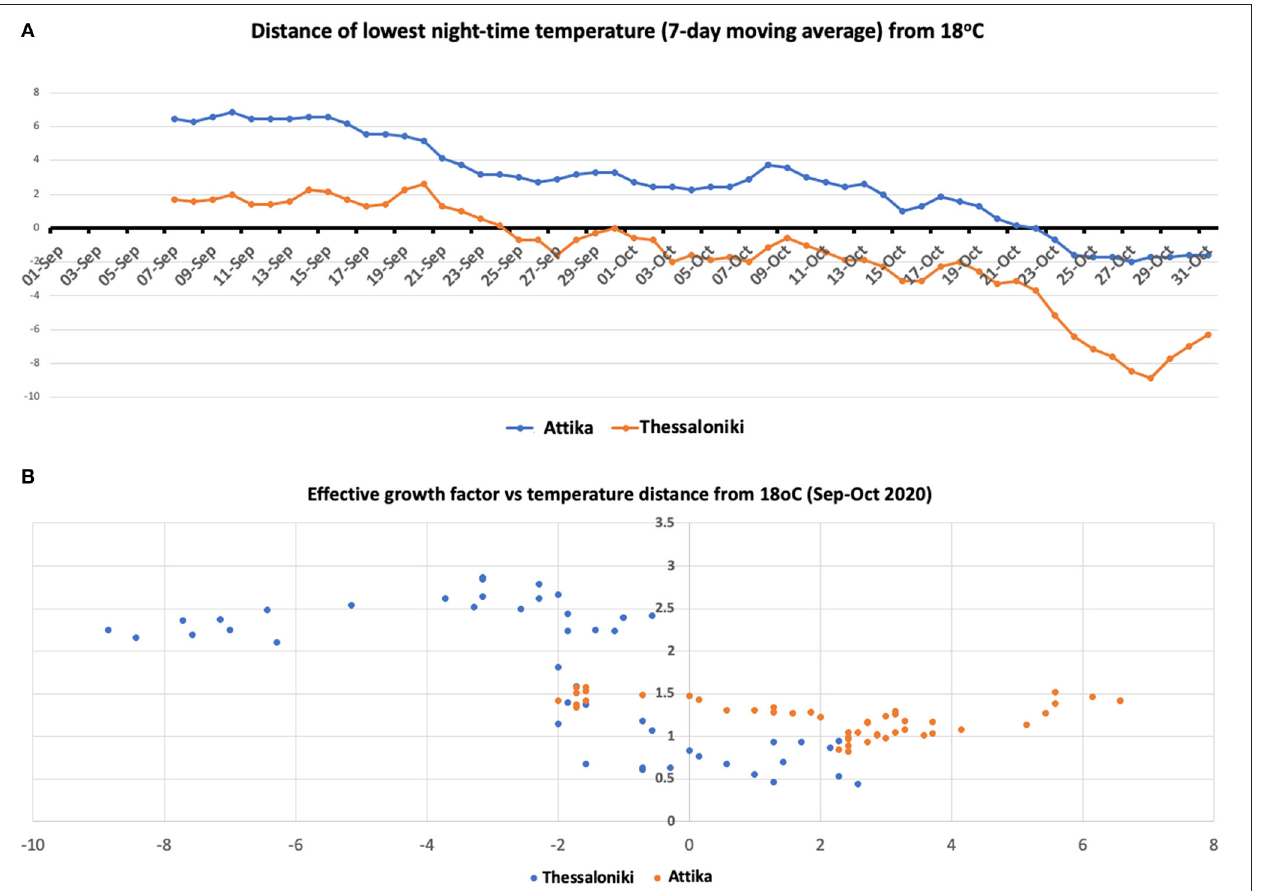
FIGURE 4 | (A) Seven-day moving average temperature difference from 18 ◦ C in Attika and Thessaloniki. (B) Scatterplot of the effective growth factor and moving average temperature difference from 18 ◦ C in Attika and